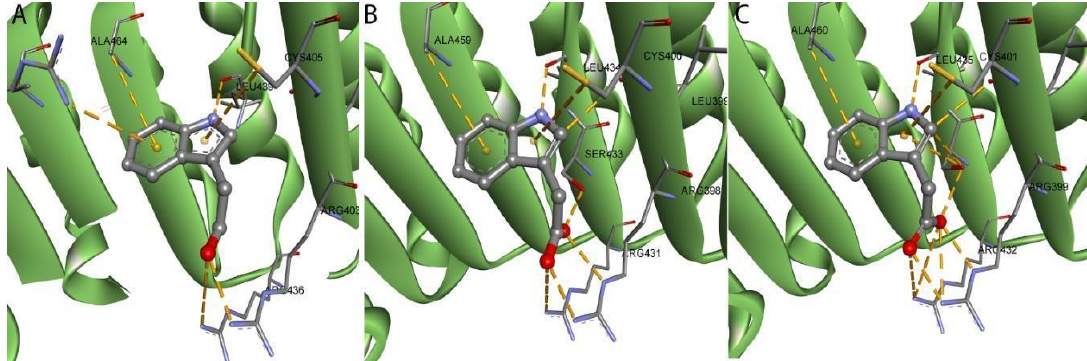
Figure 7. IAA in the AtTIR1 ( A ) CsTIR1 ( B ) and SlTIR1 ( C ) binding site. The secondary structure of the TIR1 is shown in green. IAA is shown as balls and sticks representation, while the amino acids from the binding site are shown with sticks. All interactions are shown as orange dashed lines.